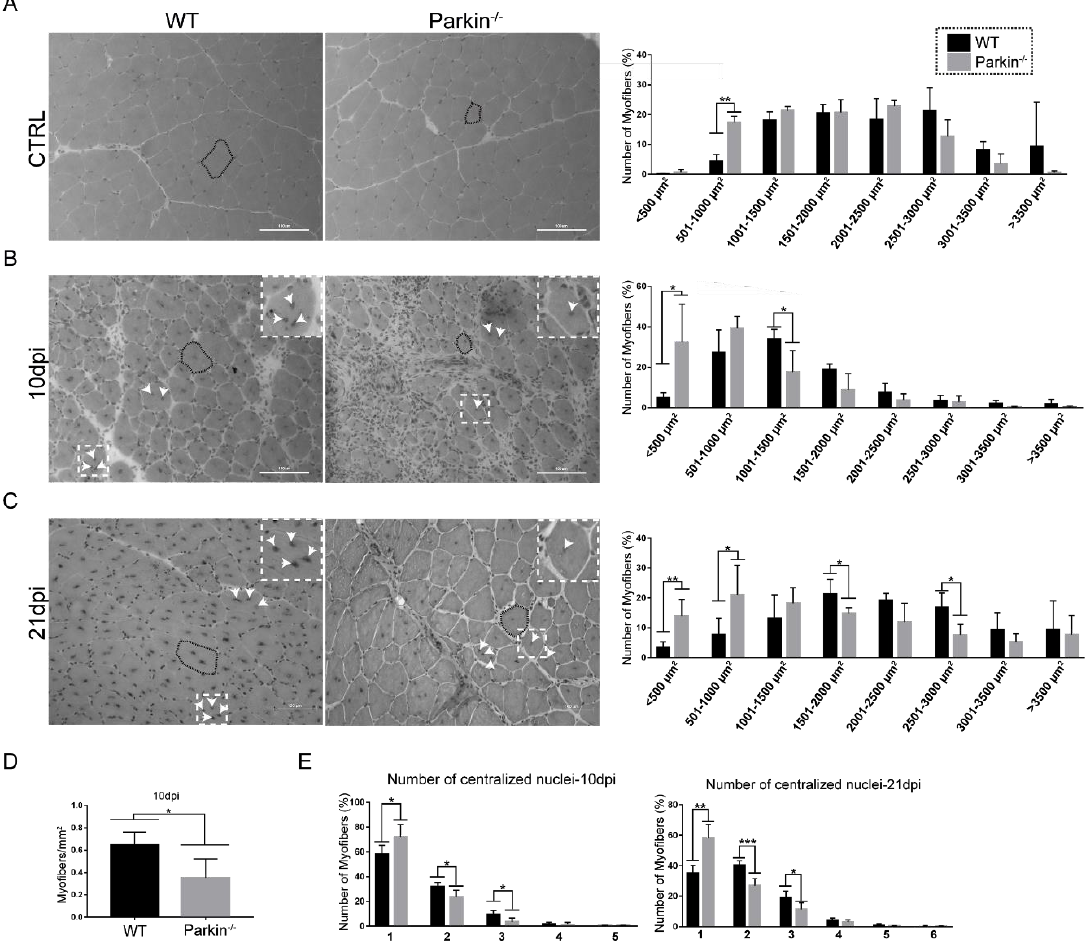
Figure 4. Loss of Parkinimpairs assembling of myofibres and growth of myofibers post-injury. ( A ) Hematoxylin and eosin staining in TA muscle cryosections from WT mice and Parkin − / − mice in CTRL. The dotted areas demonstrate how the myofibers were circled for CSA analysis. Respective graph of CSA distribution profile in TA muscle myofibers. Data represent means ± SD ( t -test: ** p < 0.01; n = 5). The images were acquired with a 20 × objective. Bars represent 100 µ m. ( B ) Hematoxylin and eosin staining of TA muscle cryosections from WT and Parkin − / − mice at 10dpi. The black dotted areas demonstrate how myofibers were circled for CSA analysis, the white arrows indicate the centralized nuclei. Respective graph of CSA distribution profile of TA muscle myofibers. Data represent means ± SD ( t -test: * p < 0.05; n = 5). The images were acquired with a 20 × objective. Bars represent 100 µ m. ( C )Hematoxylin and eosin staining of TA muscle cryosections from WT and Parkin − / − mice at 21dpi. The black dotted areas show how the myofibers were circled for CSA analysis, the white arrows indicate the centralized nuclei. Respective graph of CSA distribution profile of TA muscle myofibers. ( t -test: * p < 0.05; ** p < 0.01; n = 5). The images were acquired with a 20 × objective. Bars represent 100 µ m. ( D ) Quantitation of myofibers with centralized nucleus per mm 2 in TA muscle from WT and Parkin − / − mice at 10dpi. Data represent means ± SD ( t -test: * p < 0.05; n = 5). ( E ) Quantitation of centralized nuclei per cell in TA muscle myofibers from WT and Parkin − / − mice at 10 and 21dpi. Data represent means ± SD ( t -test: * p < 0.05; ** p < 0.01 and *** p < 0.001; n =